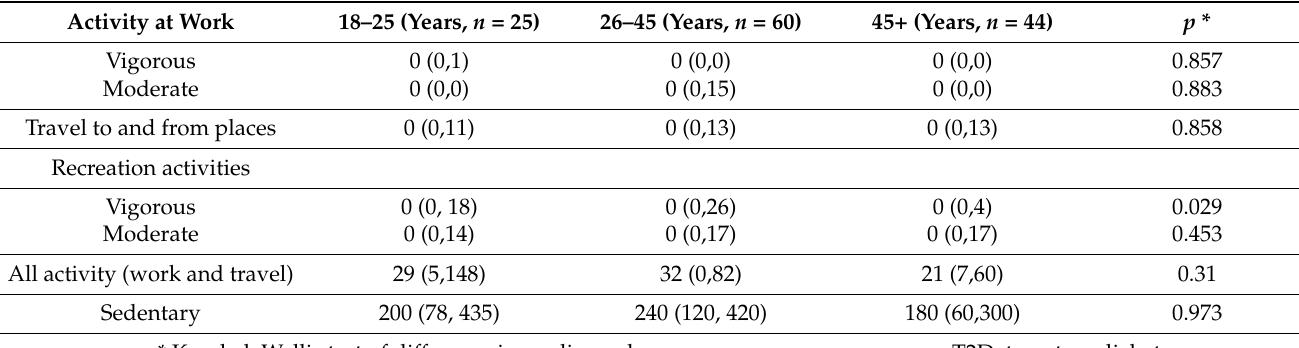
Table 2. Physical activity (minutes per day) stratified by type of activity and age category. Data are median (interquartile